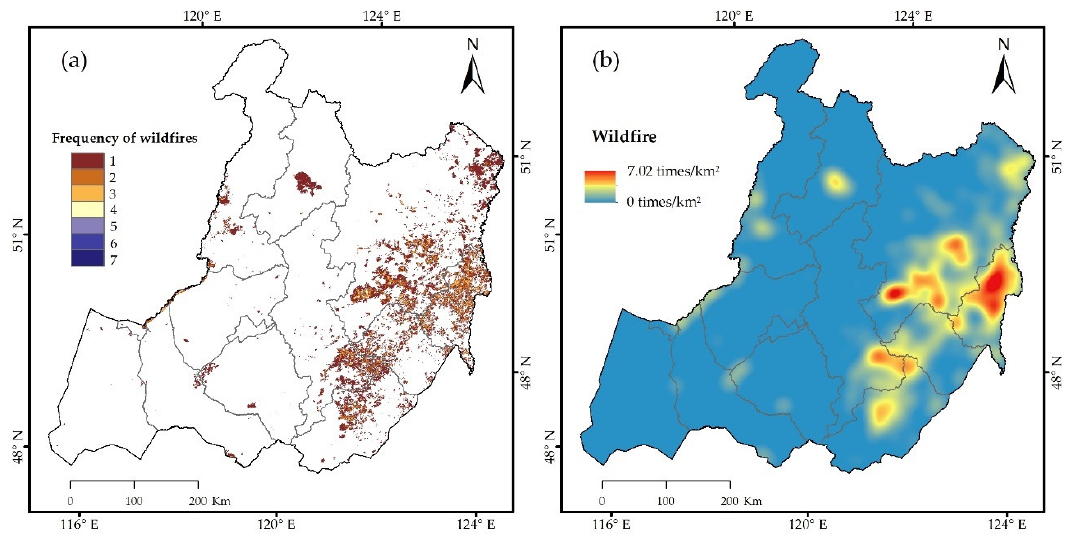
Figure 3. The distribution frequency ( a ) and density ( b ) of SWFs during the period of 2001–2018.